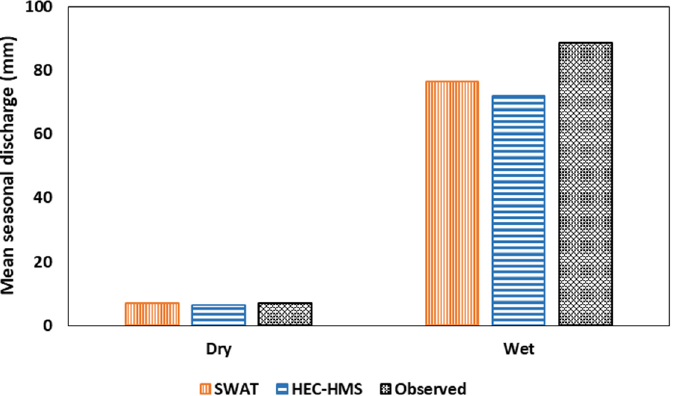
Figure 8. Mean seasonal discharge for observed as well as the HEC-HMS and SWAT models for the period period 2007–2014.